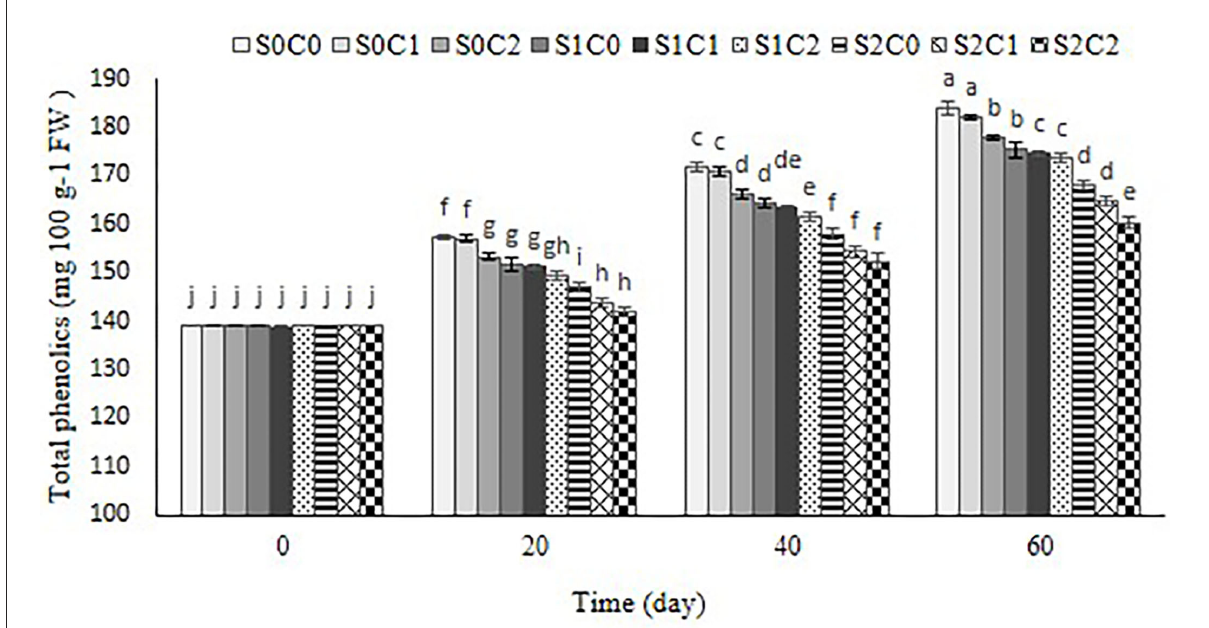
FIGURE7 Effect of foliar spraying of SA and caraway oil coating on total phenolic during 60 d of storage at 4 ± 2 ◦ C plus shelf life (2 d, 20 ◦ C). S0C0: control, S0C1: 0.3% caraway oil, S0C2: 0.6% caraway oil, S1C0: 1.5mM Salicylic acid, S1C1: 1.5mM Salicylic acid + 0.3% caraway oil, S1C2: 1.5mM Salicylic acid + 0.6% caraway oil, S2C0: 3mM Salicylic acid, S2C1: 3mM Salicylic acid + 0.3% caraway oil, S2C2: 3mM Salicylic acid + 0.6% caraway oil. Values represent mean ± SD of three replications. Different letters indicate significant differences at the 5% level according